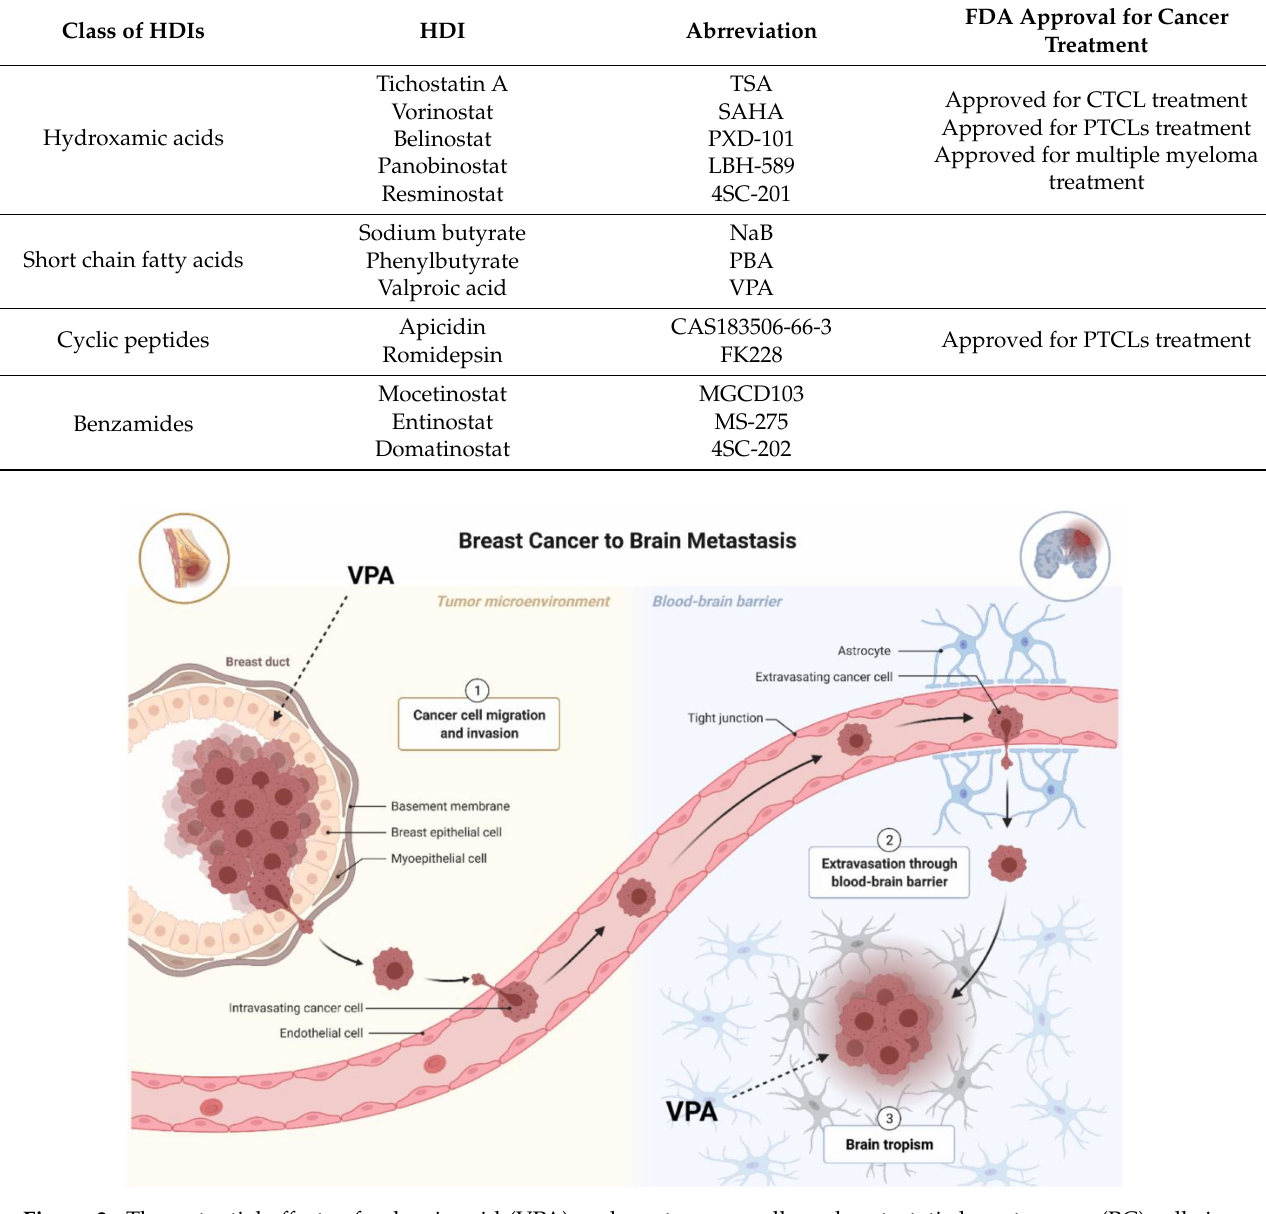
Figure 3. The potential effects of valproic acid (VPA) on breast cancer cells and metastatic breast cancer (BC) cells in the